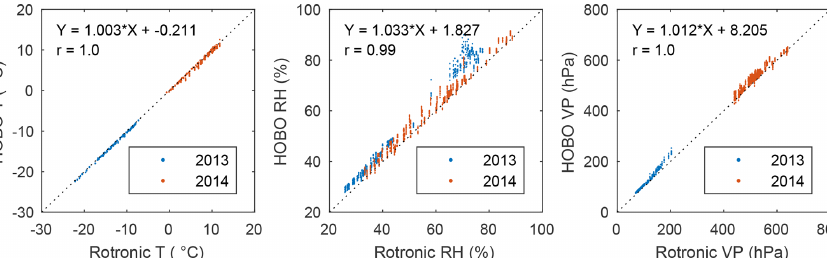
Figure 8. Hourly-averaged data from all HOBO sensors compared to the Rotronic sensor for the calibration periods in 2013 (5–8 April) and 2014 (15–18 April). Equations of the best-fit lines and correlation coefficients are listed in each panel.